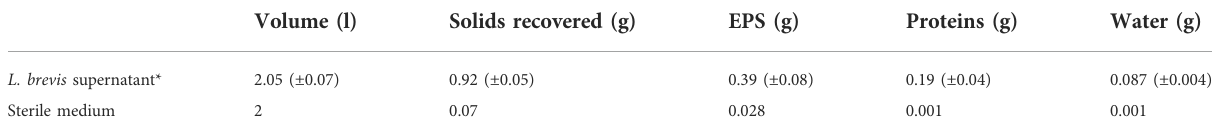
TABLE3Quanti fi cationofexopolysaccharides,proteinsandwaterinthepartiallypuri fi edsupernatantobtainedfrom L.brevis SP48fermentationson medium3withglucoseasmaincarbonsource.Datarecordedfromthecharacterizationofpowdersobtainedfromtwodownstreamprocessesof two different batch processes were used to calculate average